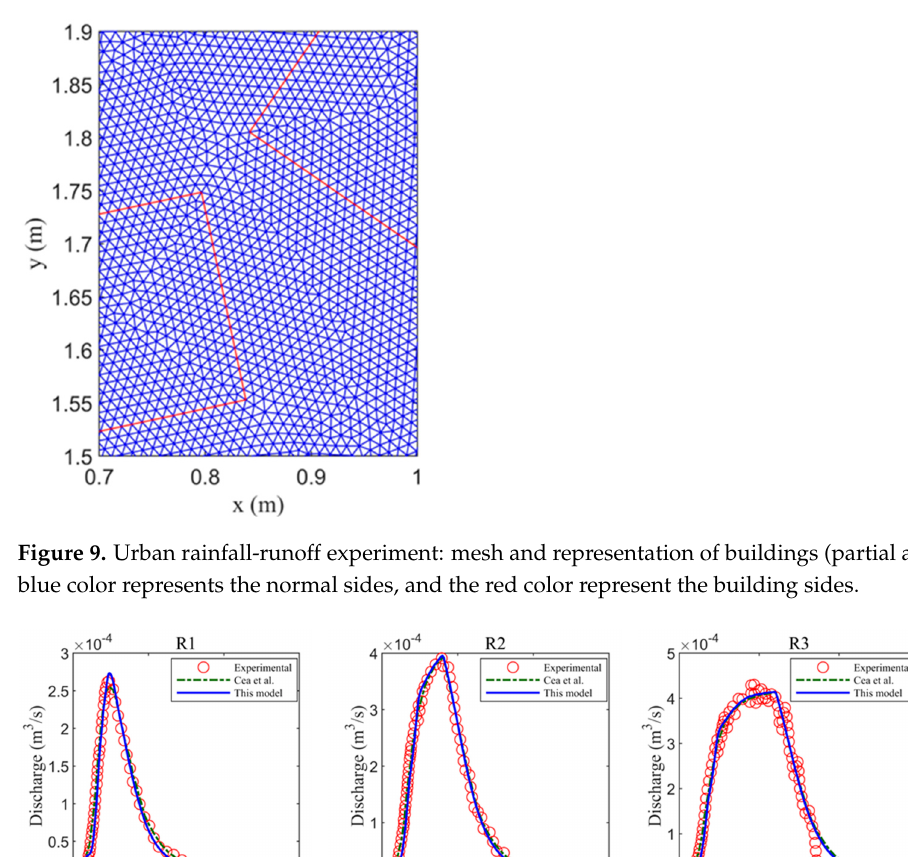
Figure 10. Urban rainfall-runoff experiment: simulated and measured outlet discharges.